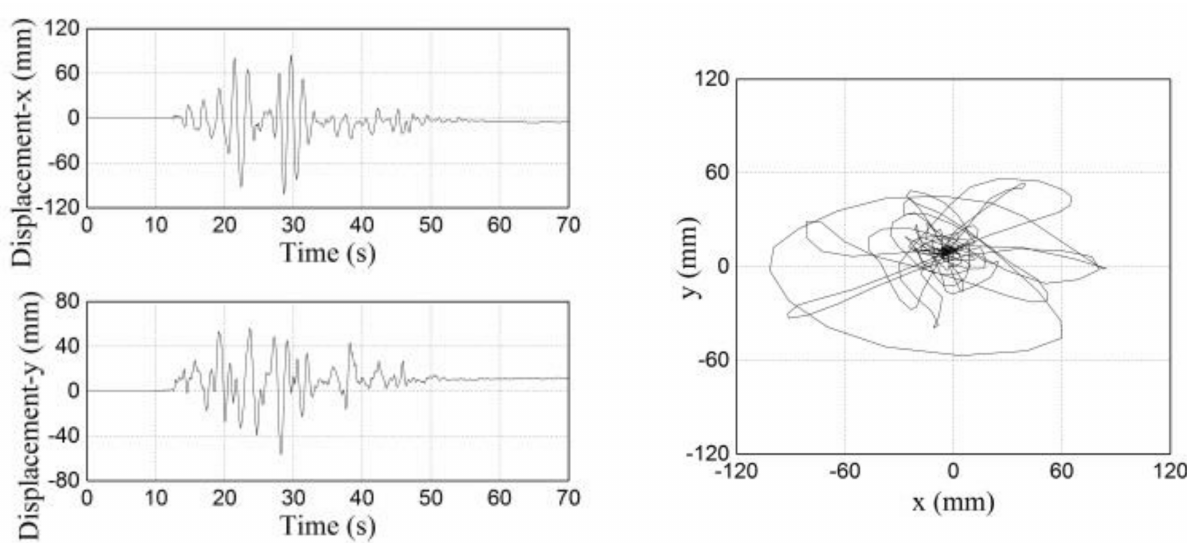
Figure 31. The relative displacements and movement locus of the b200d380 bearing subjected to ChiChi-TCU122 (low-frequency) ground motion when PGA = 2 m/s 2 .